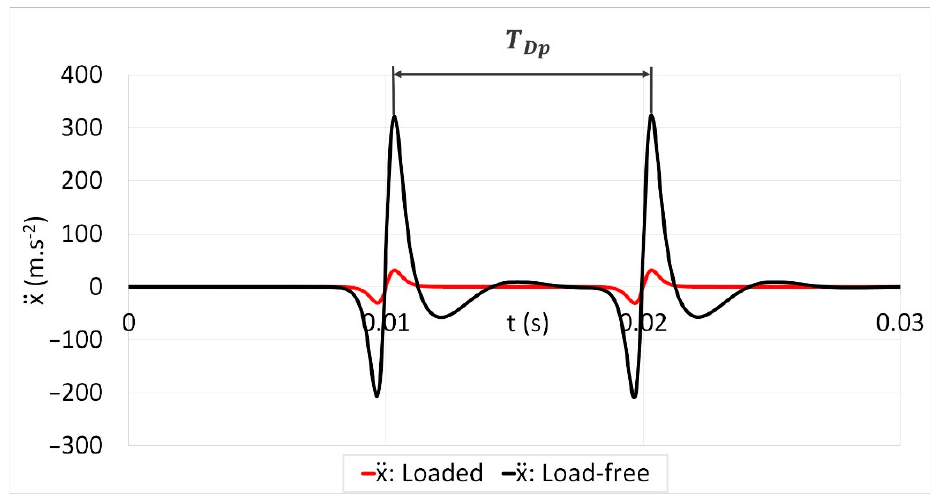
Figure 17. The time relation of mass acceleration—the influence of the mass inertia.